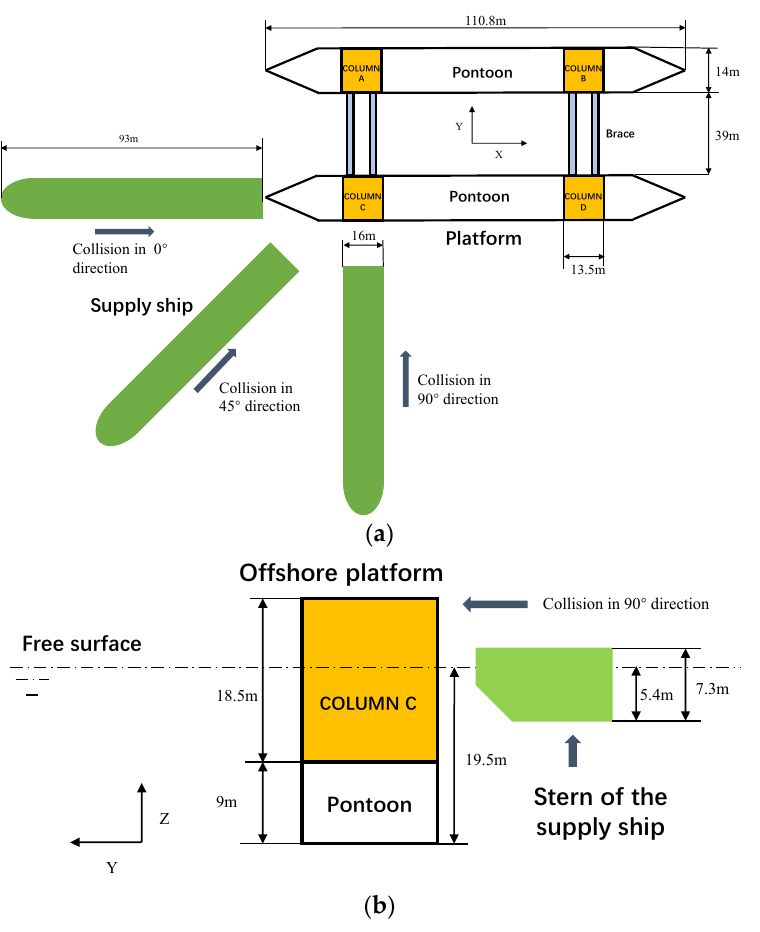
Figure 1. The collision sketch between the supply ship and support platform. ( a ) Top view of collision of offshore platform and ship in different directions. ( b ) Side view of the collision in 90° direction in the H2 condition.